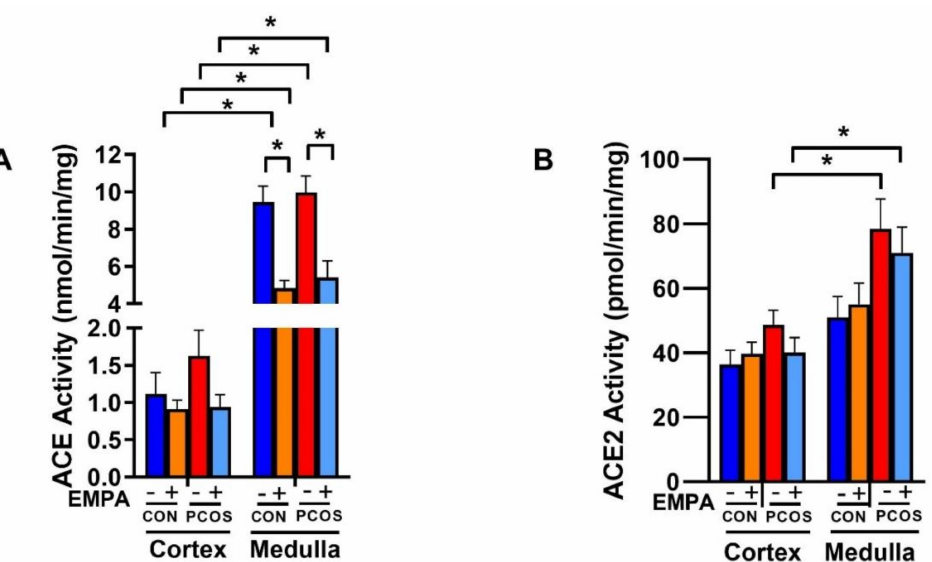
Figure 8. Effect of EMPA on ACE and ACE2 enzymatic activity in PCOS. Effect of EMPA on the renal cortical and medullar ( A ) angiotensin-converting enzyme (ACE) and ( B ) angiotensin-converting enzyme 2 (ACE2) enzymatic activity after 3 weeks of EMPA treatment. Data are expressed as mean ± SEM. Data were analyzed by three-way ANOVA followed by Tukey post-hoc tests.